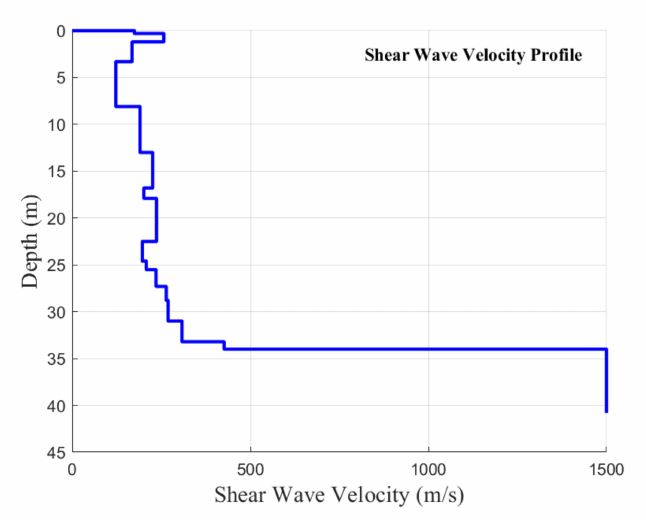
Figure 4. Case Study Output—shear wave velocity